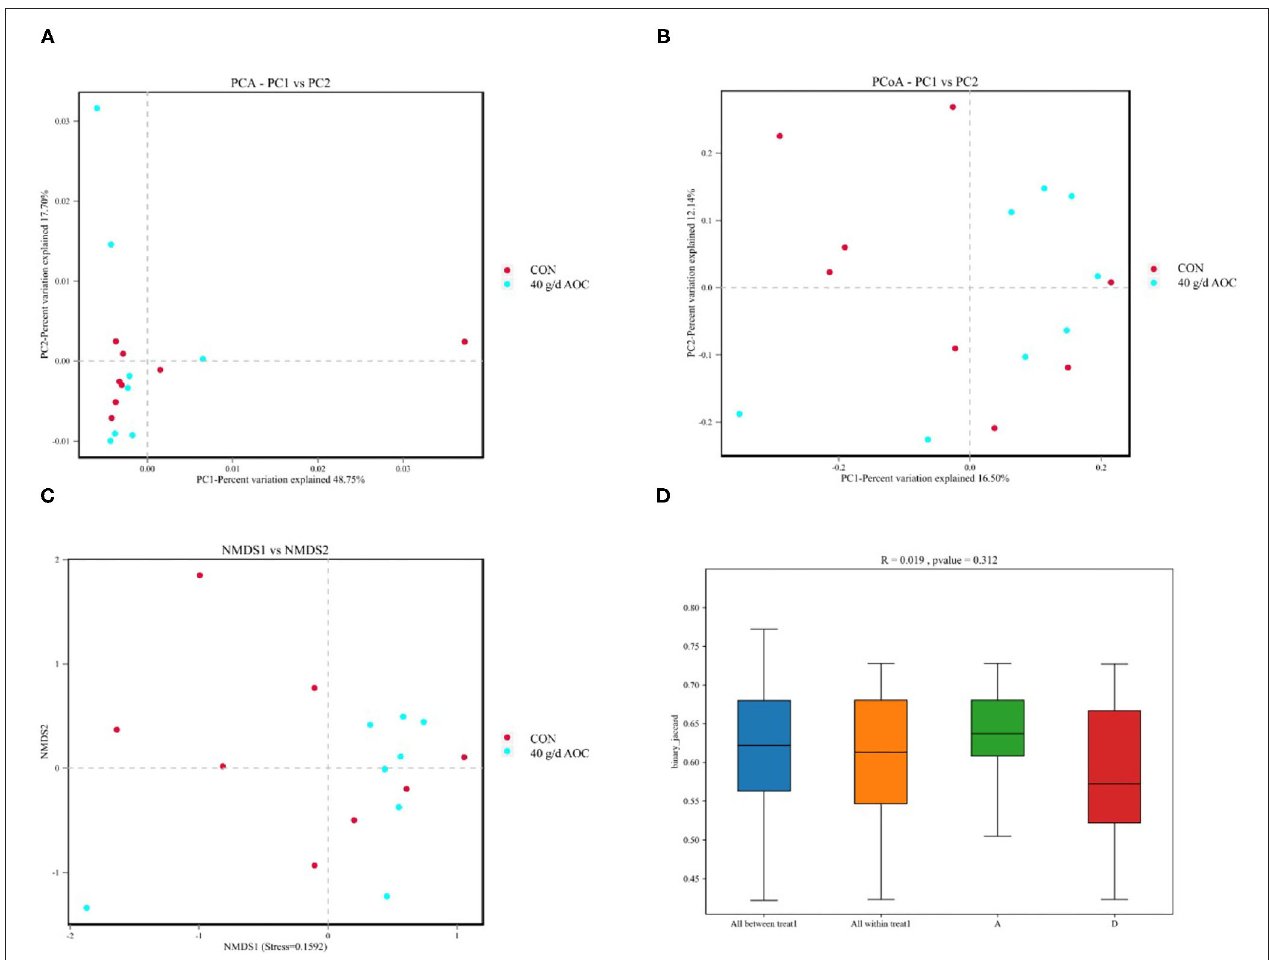
FIGURE 3 | Beta diversity analysis of Aspergillus oryzae culture supplementation on rumen microbial community of Hu sheep. Points represent each sample; different colors represent different groups. (A) PCA, Principal component analysis; (B) PCoA, Principal coordinates analysis; (C) NMDS, Nonmetric multi-dimensional scaling; (D) Permanova (Adonis)